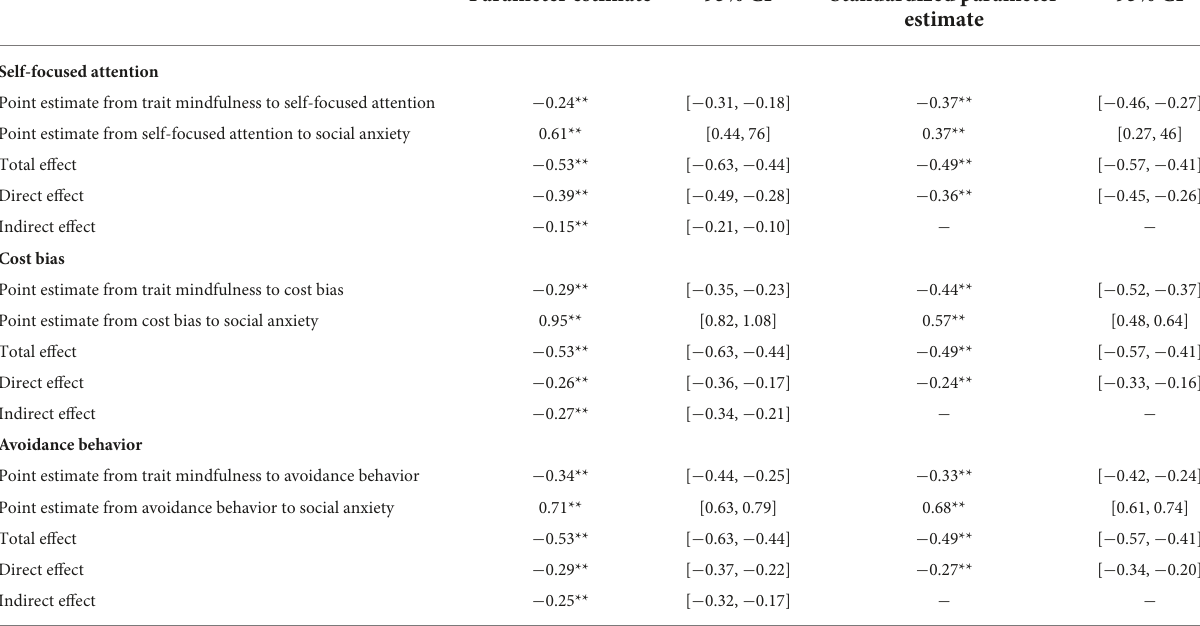
Parameter estimate 95% CI Standardized parameter 95% estimate